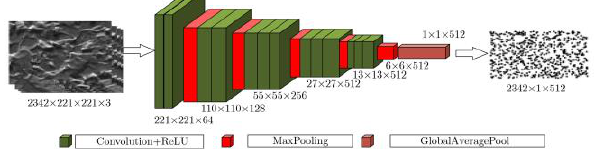
Figure 4. VGG16 convolution module is used to extract text